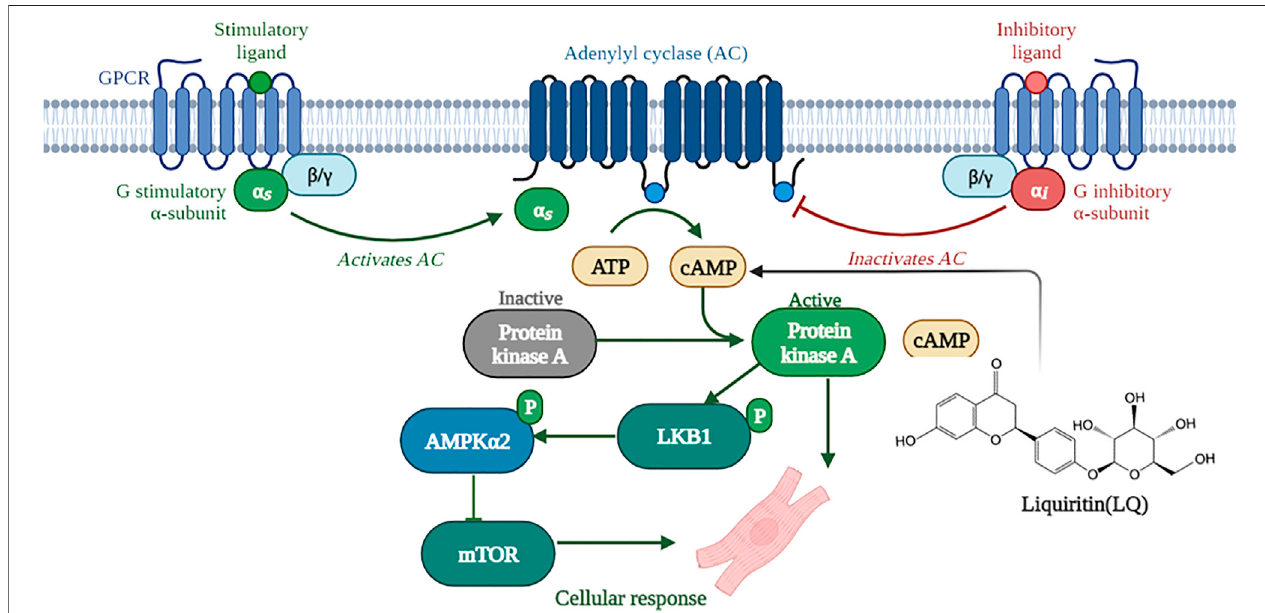
FIGURE 10 | Schematic depiction of the mechanisms underlying liquiritin-mediated protection against cardiac hypertrophy (Created with BioRender.com).